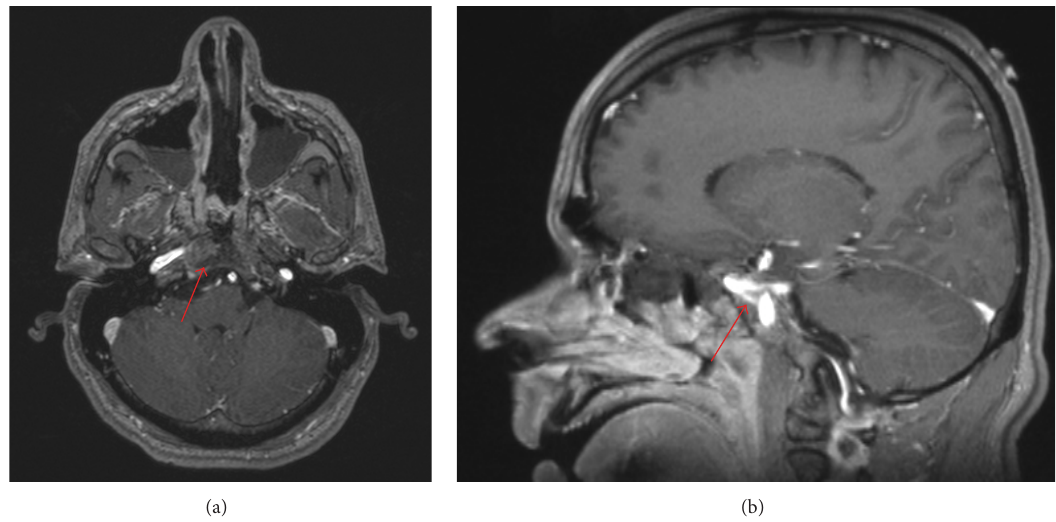
Figure 3: Postoperative magnetic resonance imaging, with contrast, axial (a) and sagittal (b) sections, demonstrating a small amount of residual